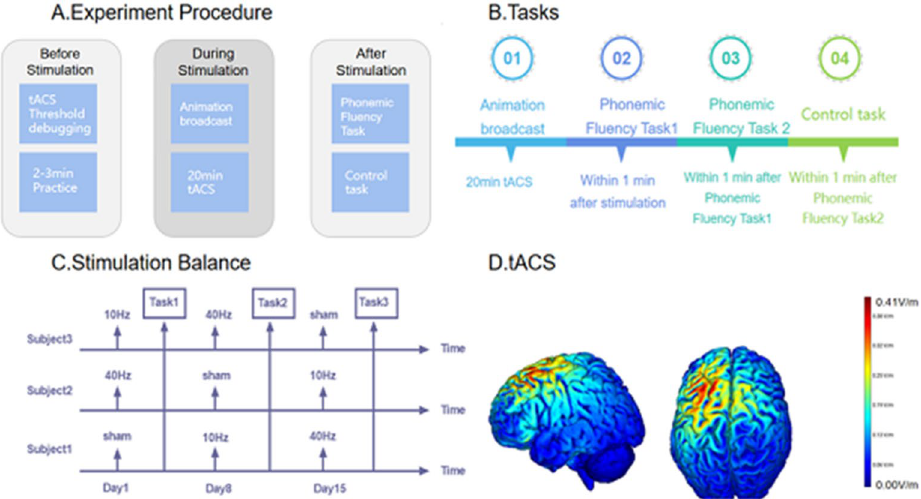
Figure 1. Experimental design. ( A ) Time-course of the experiment. At the beginning of each session, we completed a tACS threshold debugging, participants performed a short training of the phonemic fluency task. After 20 min of tACS, subjects performed two phonemic fluency tasks and a control task ( B ) Tasks. (1) Phonemic fluency task. Requires subjects to say words according to a certain consonant limited in 1 min. (2) Control task. Directional arrows were presented visually and subjects had to indicate their direction by pressing the corresponding button. ( C ) The order of stimulations. Each subject will be given three stimuli in three sessions.Each stimulus has an interval of 7 days. ( D ) Simulation of the electric field of the